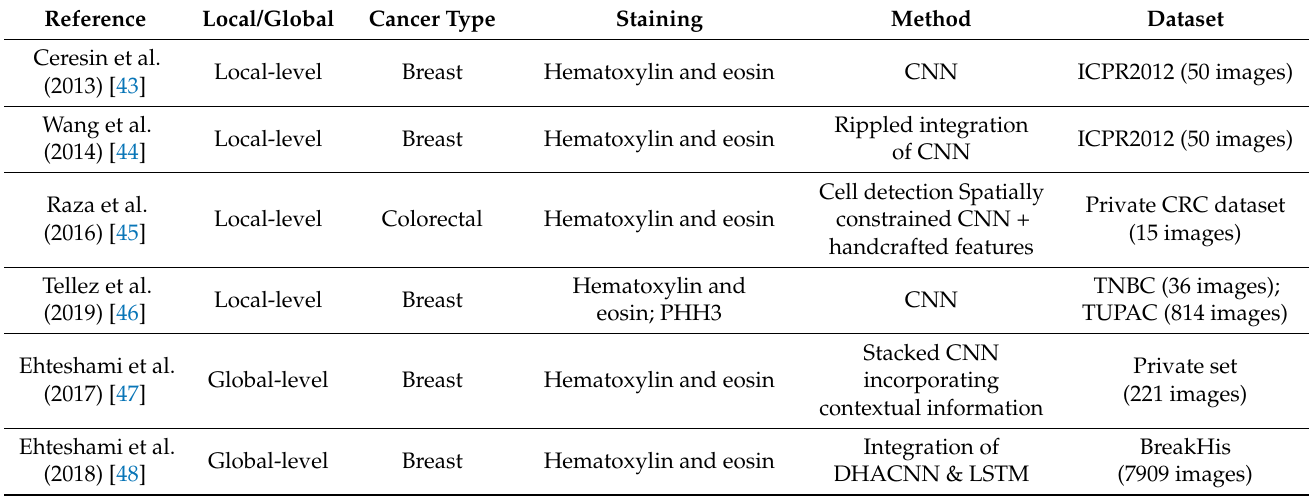
Table 1. A review of supervised learning models. The staining abbreviations stand for H&E